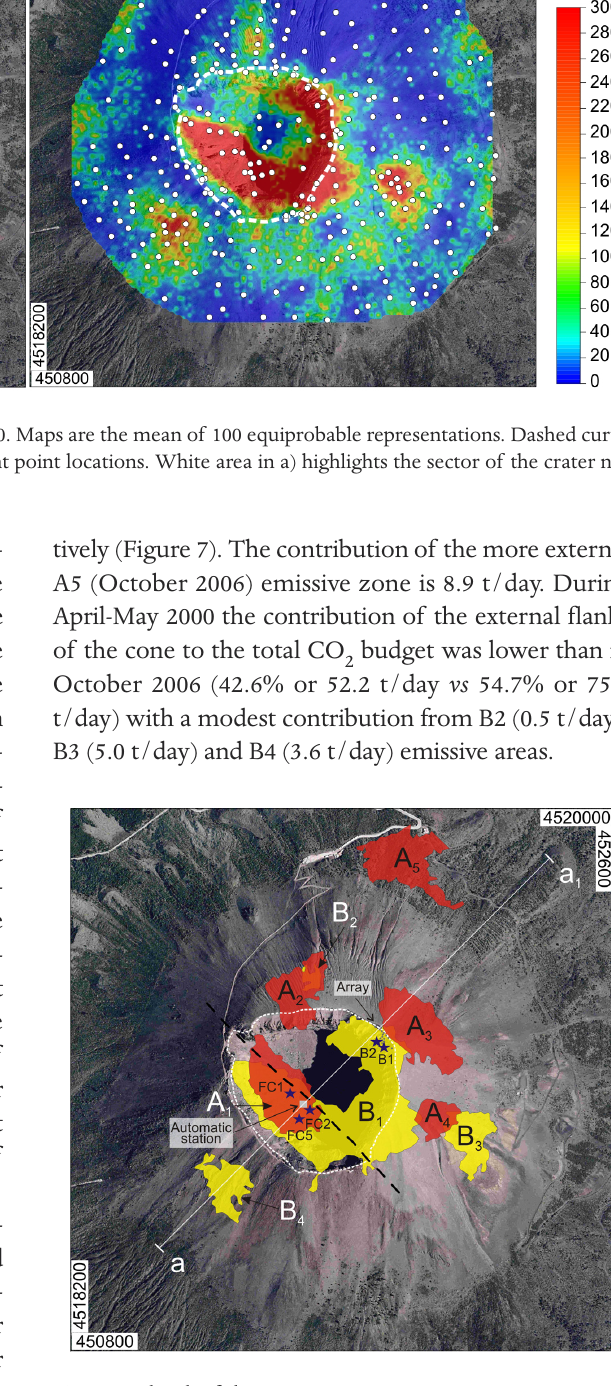
Figure 7. Sketch of the more emissive areas at Vesuvio cone. Each flux is higher than 100 g m -2 d -1 . area contours the zone were CO 2 areas), yellow colour Red colour refers to October 2006 survey ( A n to the April-May 2000 survey ( B areas). The location of the fu- n maroles in the bottom of the crater (FC1, FC2 and FC5) and over the rim (B1 and B2) is also shown, such as the position of the auto- matic station and of the 15-point array. Bottom crater fumaroles have a temperature of about 95° (i.e. the T of the satured steam at the altitude of the crater), whereas rim crater fumaroles have tem- line is the trace of the cross perature of 62°C to 75°C. Finally, a-a 1 section reported in Figure